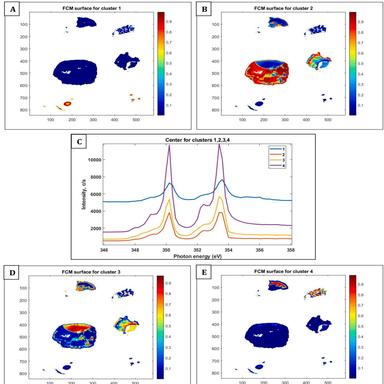
Fuzzy C-Means (FCM) clustering analysis of the NMI region after annealing. Clusters 1 through 4 are visualized in panels A to E, respectively, with the membership probabilities indicated by the color scale. Panel C presents the centroid spectra for each cluster, with lines corresponding to the cluster numbers shown in panels A, B, D, and E.